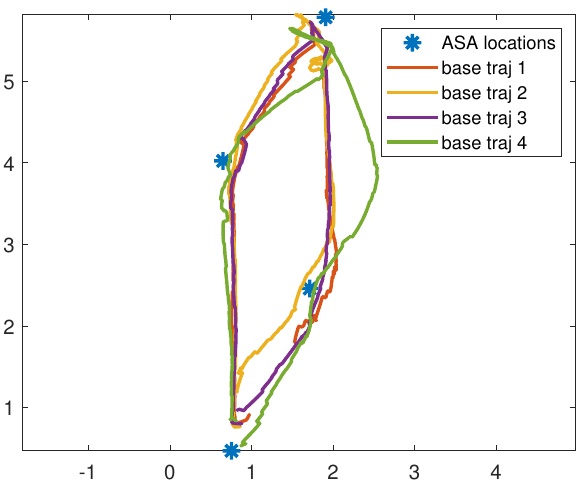
Figure 10. Plot of robot base trajectories for four trials with respect to the ASA locations. The base moves within a neighborhood of each ASA. At ASA 2, which is the cart, it performs the barcode identification and object grasping